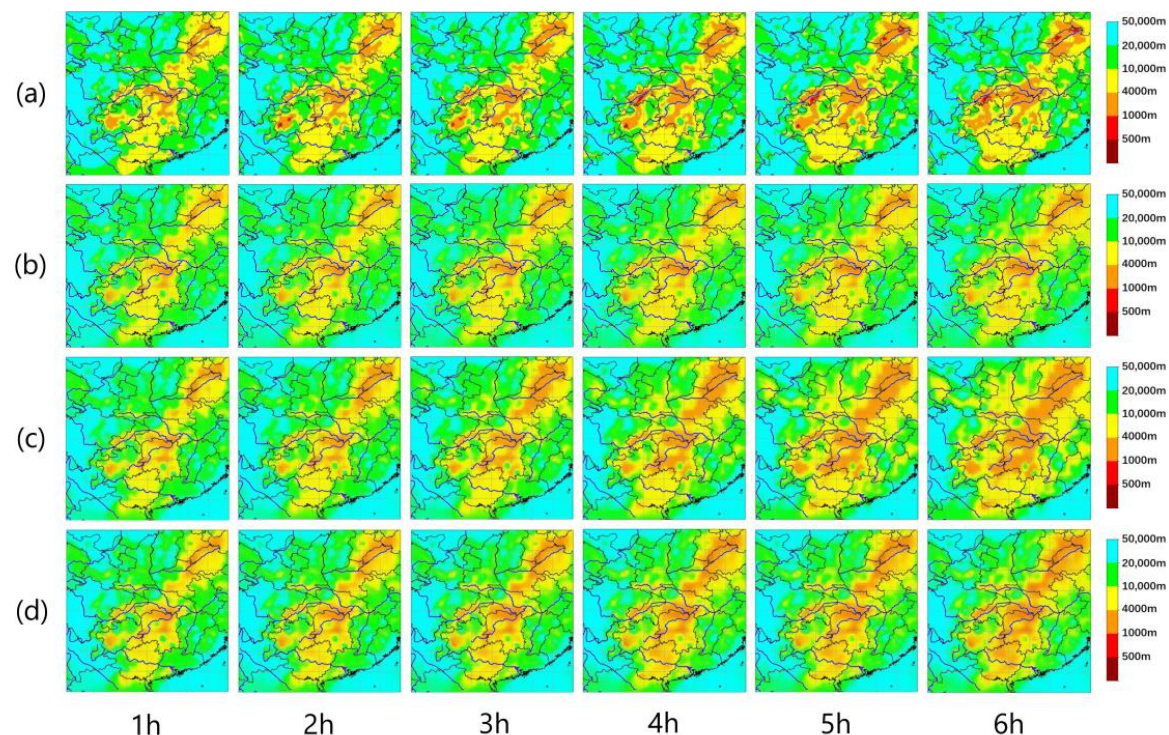
Figure 5. Observed and predicted images on 31st October 2020 (12:00–17:00). ( a ) Observed; ( b ) ConvLSTM; ( c ) PredRNN; ( d ) SwiftRNN.